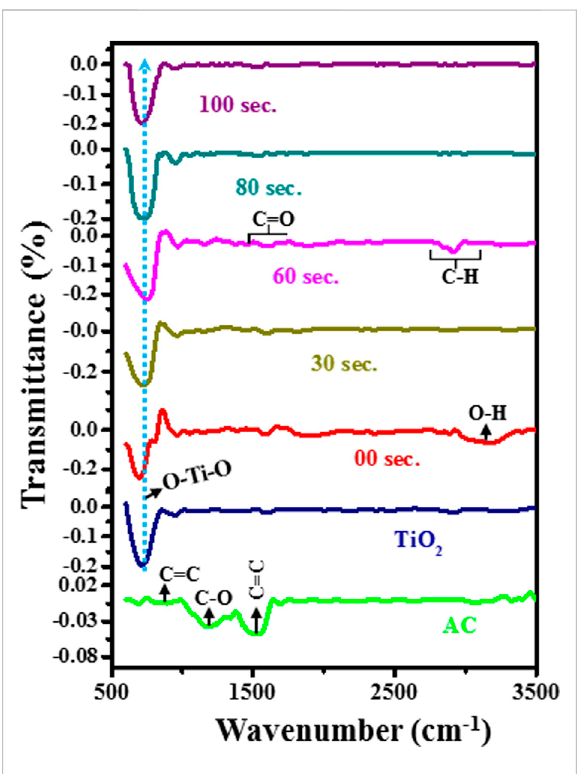
FIGURE 4 Recorded FTIR spectrum of untreated and treated